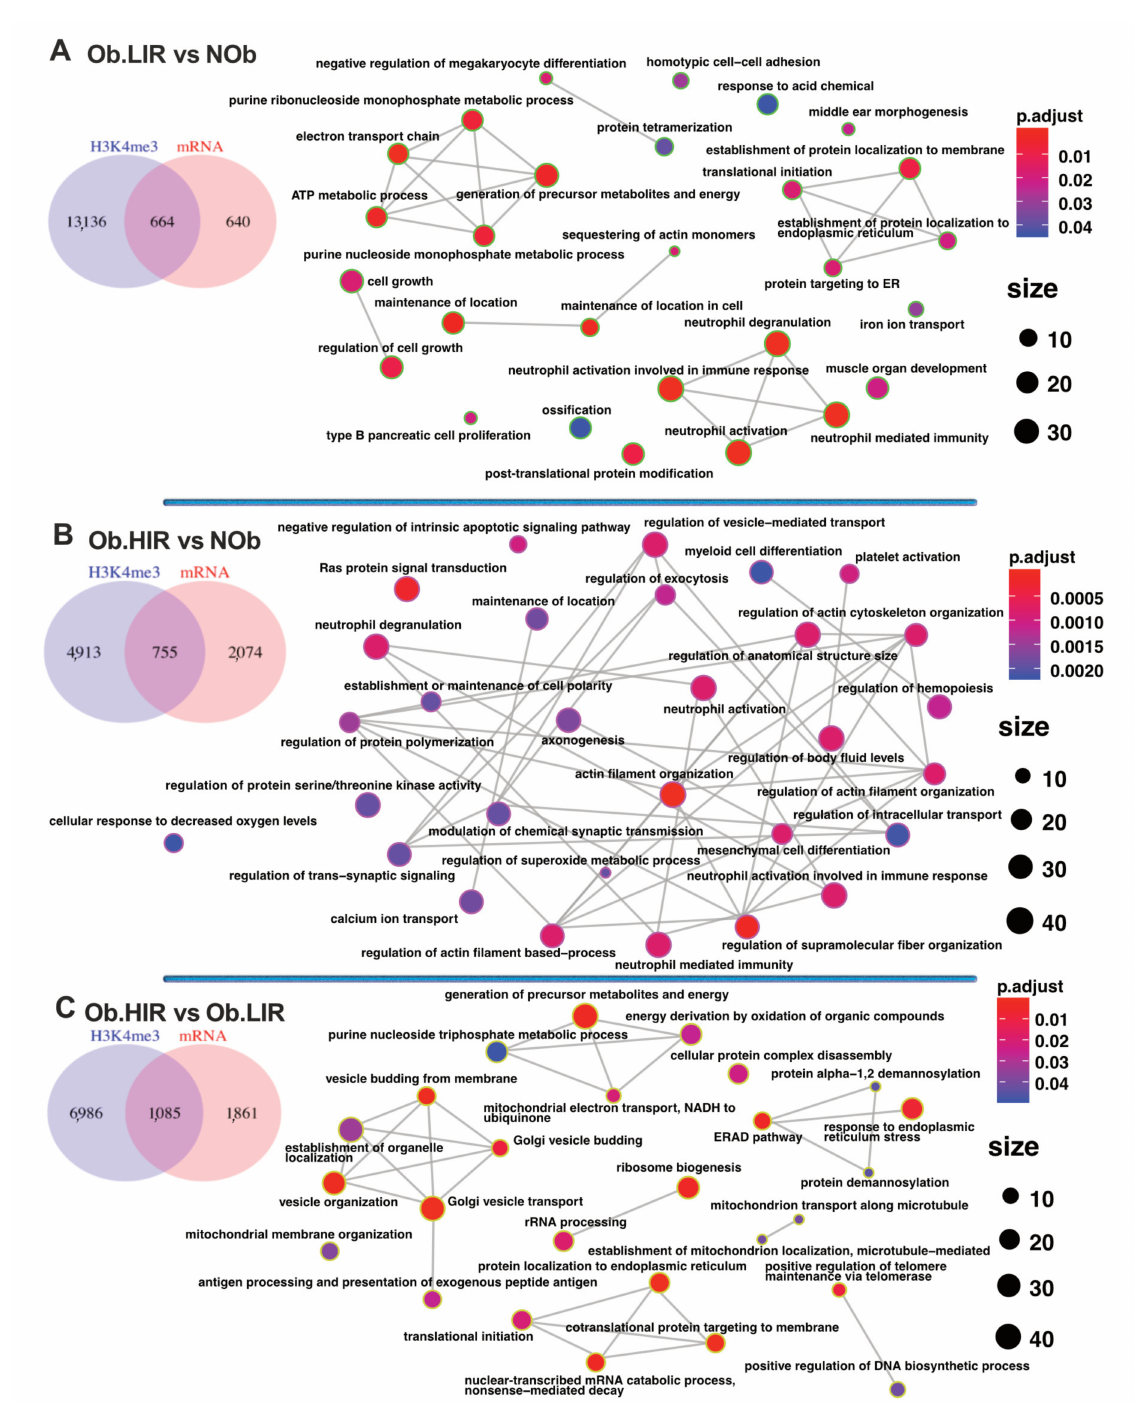
Figure 3. Intersection of genes differentially expressed (mRNA) and enriched for H3K4me3 and enriched pathway analysis for the comparison: Ob.LIR vs. NOb ( A ), Ob.HIR vs. NOb ( B ) and Ob.HIR vs. Ob.LIR ( C ). Pathways analysis for GO terms. The green, pink and yellow-green rings represent pathways enriched for the comparisons Ob.LIR vs. NOb, Ob.HIR vs. NOb and Ob.HIR vs. Ob.LIR,